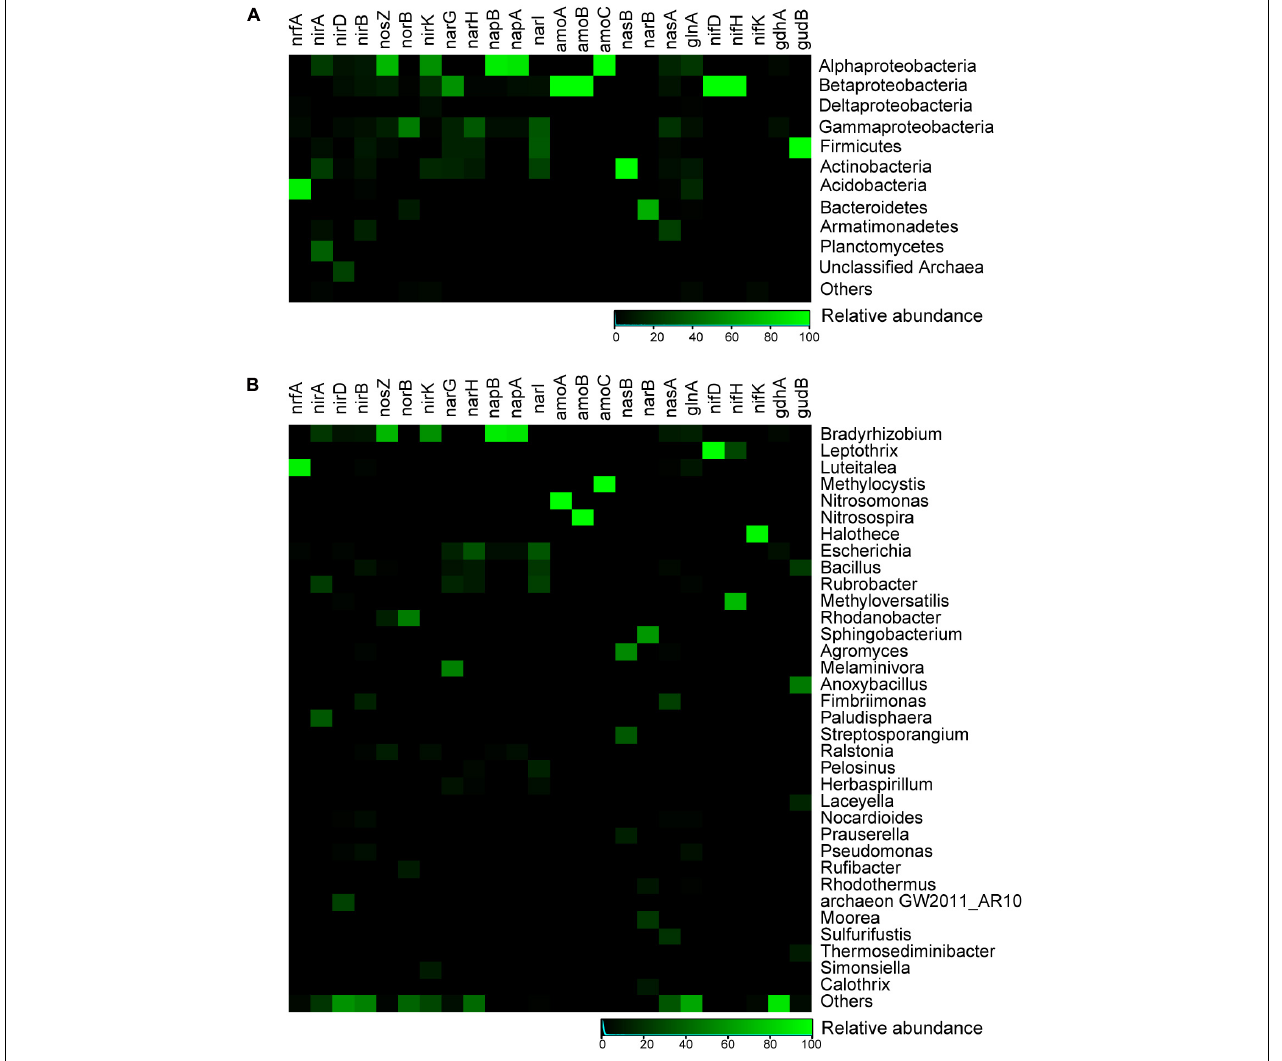
FIGURE 6 | Heatmap showing relative abundances for main microbial taxa of selected key genes related to nitrogen metabolism in the Union Glacier area. (A) At the phylum level. (B) At the genus level. Color bars represent the row-scaled value, in which a blue curve illustrates the distribution density